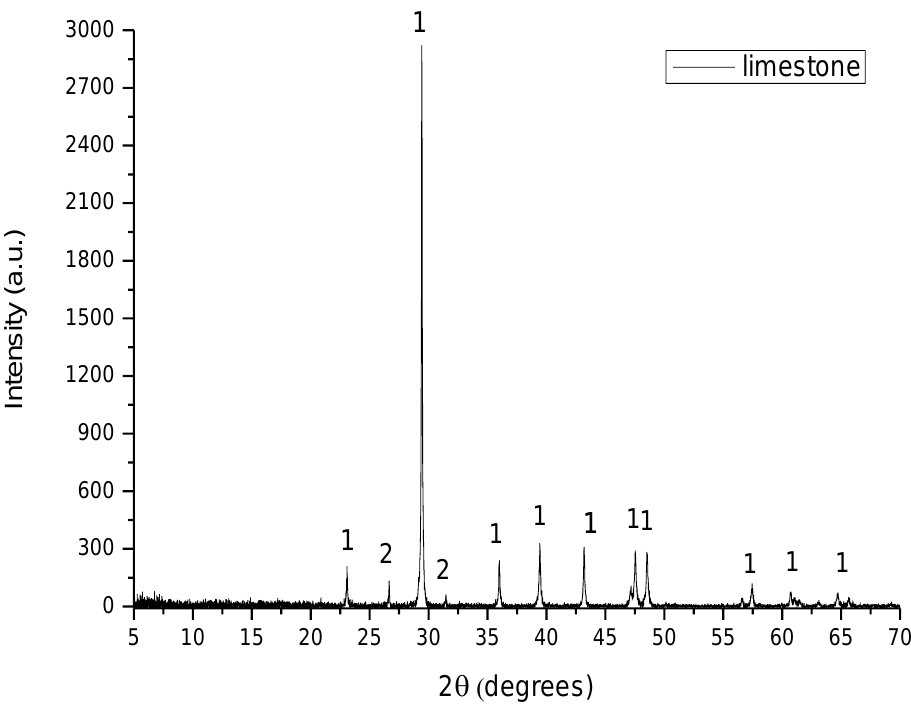
Figure 2. XRD pattern of limestone, where 1: calcite and 2: quartz.